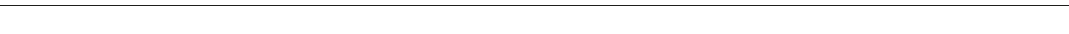
Fig. 1 Clustering and chromatin-association of long ncRNAs. a Schematic representation of the pipeline followed to de fi ne the fi nal set of long ncRNAs used in this study, and the k-means clustering parameters. b K-means clustering of 4467 long ncRNAs. Clustering parameters are histone mark signal values (ChIP-seq peaks from H3K4me3, H3K4me1, and H3K27ac in MCF-7), expression (GRO-seq 35 and chromatin-associated RNA-seq log(RPKM)), and ChIA- PET maximum interaction scores. All values were rescaled in the range 0 to 1 using min – max normalization. c H3K4me1/H3K4me3 ratio for relevant clusters, y -axis is in log scale. d Comparison of ChIA-PET interaction scores for all clusters. Marked are the clusters with the strongest interactions (ChIA- PET score median = 1 and mean > 0.9) (clusters 4, 6, 7, 13, 15). e Comparison of the long ncRNA chromatin-association character for all clusters. The ratio chromatin-associated RNA-seq RPKM to nuclear polyA + RPKM is plotted in log 2 scale. Clusters with signi fi cantly lower chromatin-association are red- marked (Wilcoxon-Mann-Whitney test p -value < 2.2e-16). f Principal component analysis (PCA) biplot showing the multivariate variation of chromatin- enriched (log2 chromatin-association > 0, red) and nucleoplasmic-enriched (log2 chromatin-association < 0, blue) long ncRNAs in terms of fi ve variables: ChIA-PET, GRO-seq, H3K4me3, H3K4me1, H3K27Ac. Points represent projections of the original values in a new space, de fi ned by a new set of variables, the principal components PC1 and PC2, which better explain the patterns in the data. The contribution of the initial variables in explaining the variance within each PC is shown in the barplot underneath. g Boxplot displaying the distribution of the DESeq2 derived log2 fold changes in expression using total chromatin-associated vs. nucleoplasmic RNA-seq, for 1154 signi fi cantly chromatin-enriched long ncRNAs (at DESeq2 p -adjusted < 0.1; Supplementary Data 2), 968 signi fi cantly nucleoplasmic-enriched long ncRNAs (Supplementary Data 3) and 1807 long ncRNAs not enriched in either of the two fractions (non-signi fi cant, ‘ NS ’ ). h Boxplot displaying the distribution of ChIA-PET interaction scores for the three sets of long ncRNA de fi ned in ( g ). Nucleoplasmic- enriched long ncRNAs show on average signi fi cantly higher ChIA-PET interaction scores (Wilcoxon-Mann-Whitney p -value = 9.462e-16 to CHR-enriched and p -value < 2.2e-16 to NS). i Boxplot displaying the distribution of DESeq2 generated log2 fold changes CHR/NP for long ncRNAs engaged in strong ChIA-PET interactions (clusters 4, 6, 7, 13, 15; n = 664) and long ncRNAs not engaged in ChIA-PET ( ‘ rest ’ ; clusters 3, 5, 12, 14; n = 1402). Wilcoxon-Mann- Whitney p -value < 2.2e-16. j Boxplot displaying the distribution of expression (GRO-seq 35 reads per kb, RPK) of long ncRNAs either engaged or not